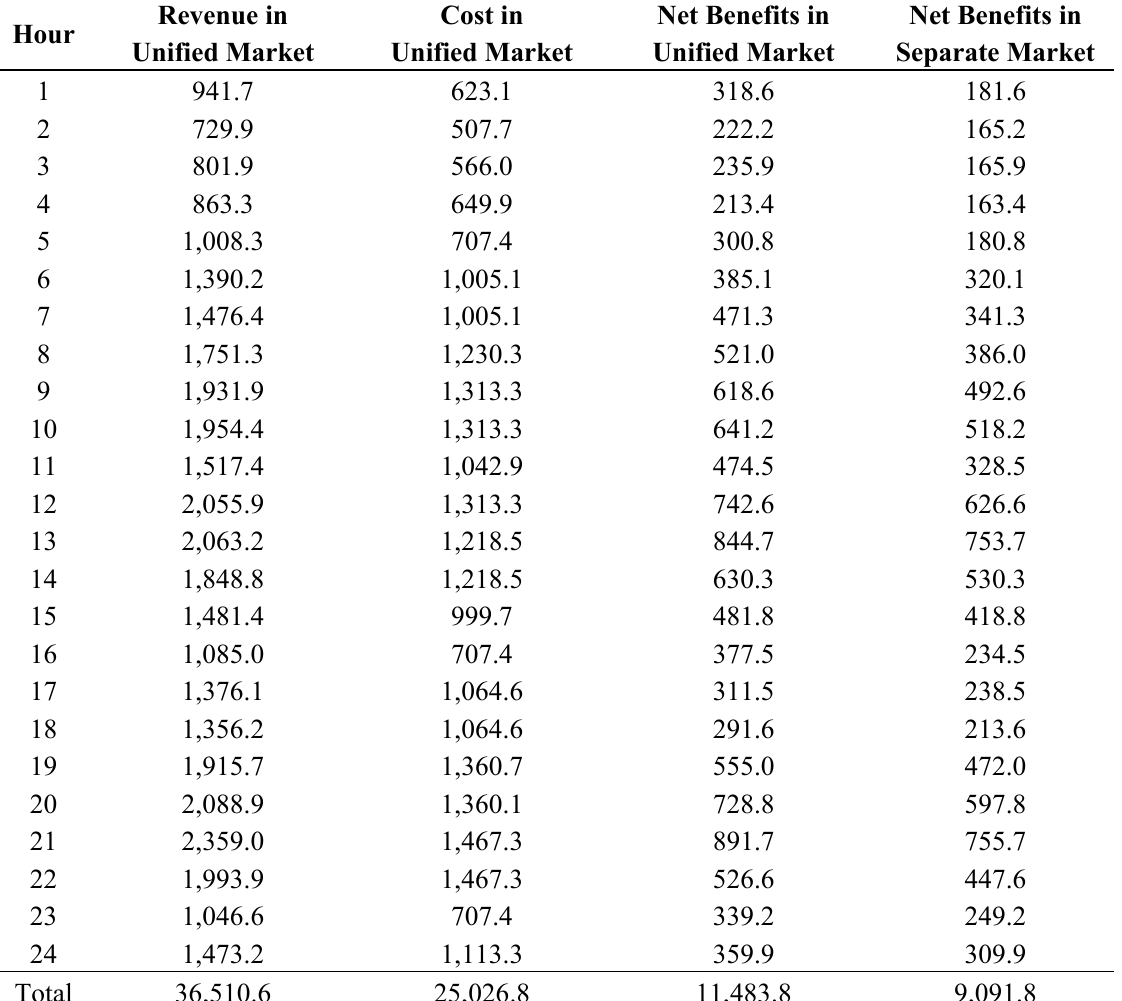
Table 3. The net benefits in a unified market and separate